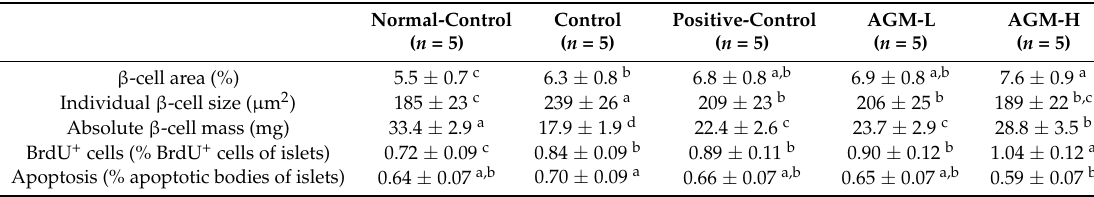
Table 5. The modulation of islet morphometry in the pancreas